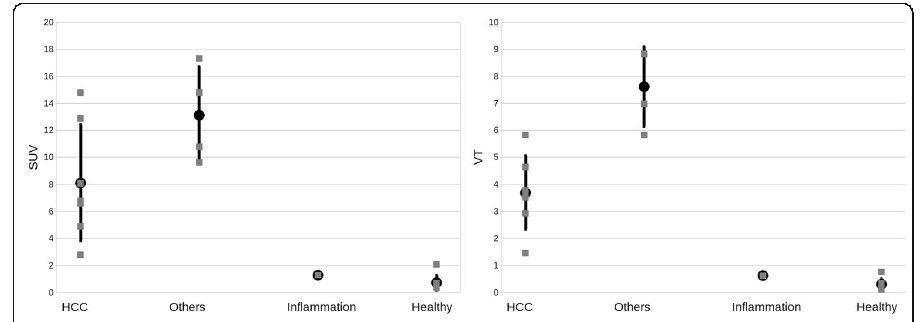
Fig. 4 For HCC lesions, non-HCC lesions, one inflammation, and healthy regions, the SUV uptake for the last 5 min (left) as well as the parameter V T derived from model AV (right) are displayed. Differences between HCC and non-HCC lesions were not significant in case of the SUV uptake (averaged 61 % difference, p = 0.08), and significant in case of V T (averaged 106% difference, p =